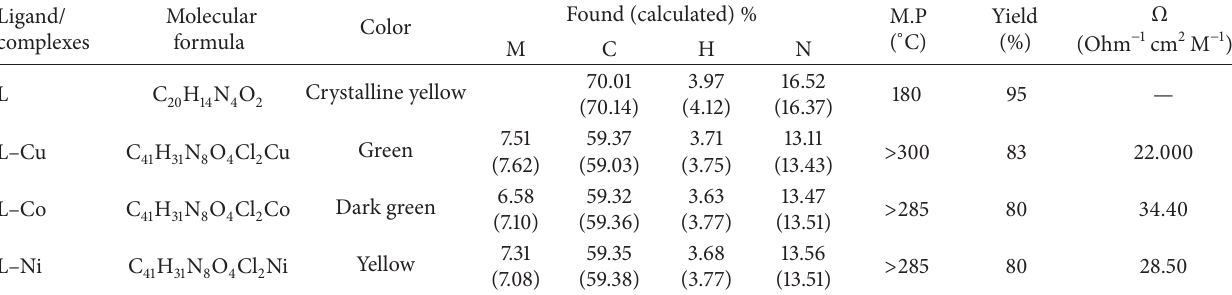
Table 1: Composition and physical characteristics of ligand and their complexes.